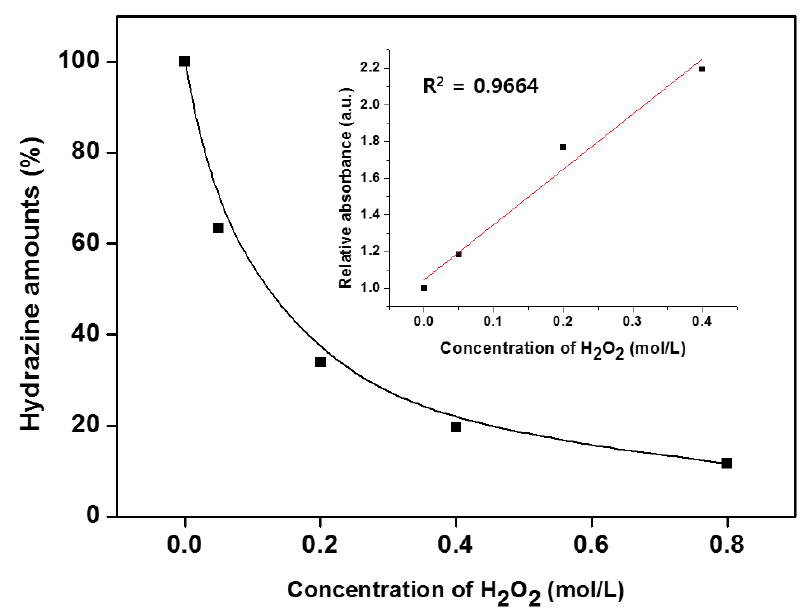
Figure 2. Effect of H 2 O 2 concentrations on absorption at 455 nm for detection of hydrazine decomposition. The insert is a calibration graph of H 2 O 2 .